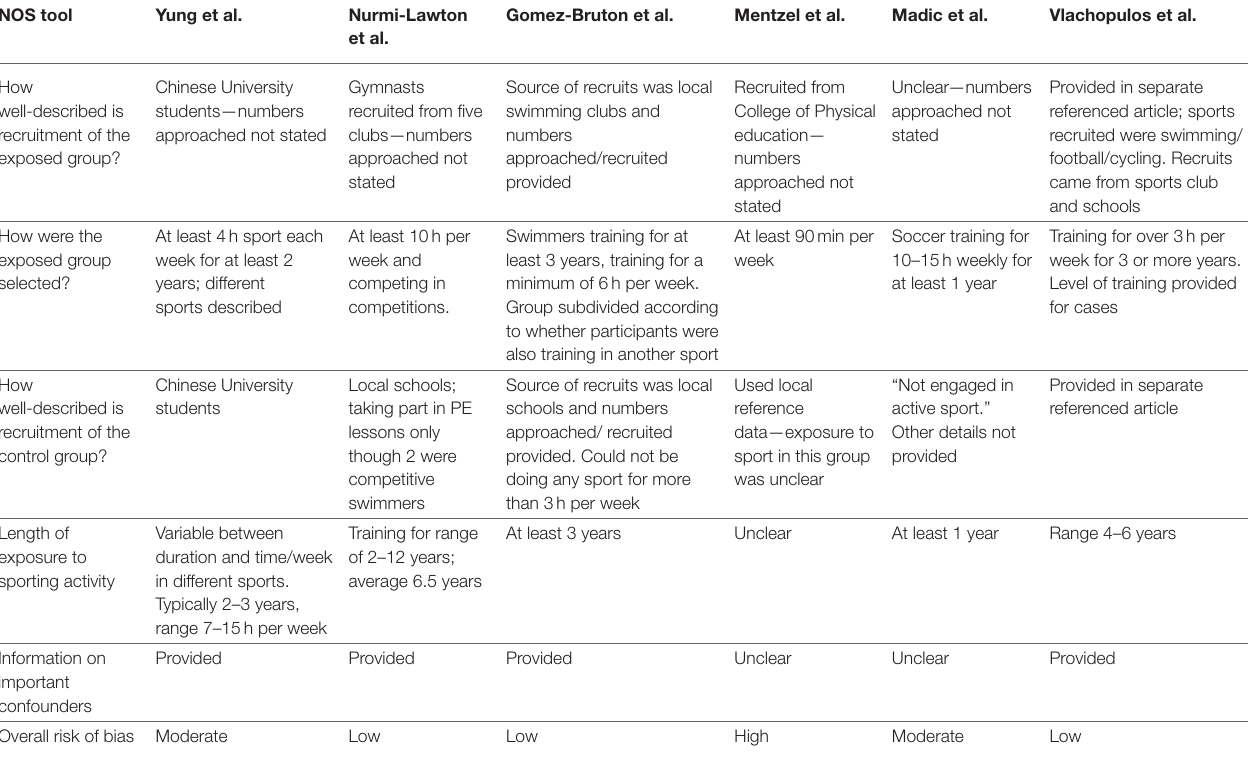
TABLE 3 | Risk of bias